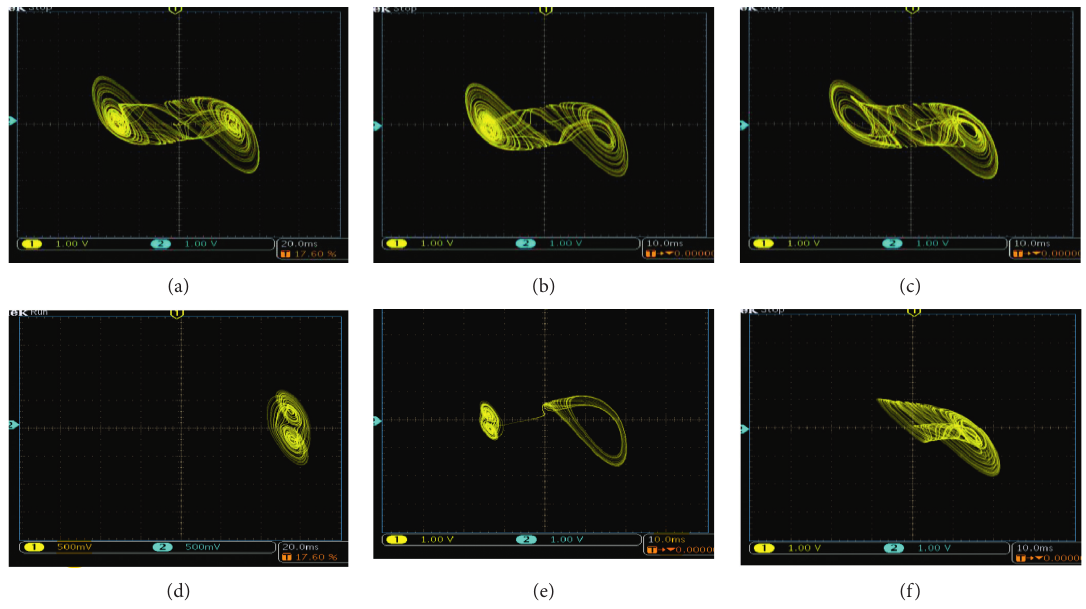
Figure 14: The screenshots of the digital oscilloscope of the different composite multiscroll attractors with different R scroll with R 3 � 2.86k Ω ; (b) composite 4-scroll with R 3 � 3.3k Ω ; (c) double-scroll with R 3 � 0.5k Ω ; (d) double-scroll with R 3 � 4.348k Ω ; (e) composite 3-scroll with R 3 � 3.362k Ω ; (f) single-scroll with R 3 � 0.263k Ω